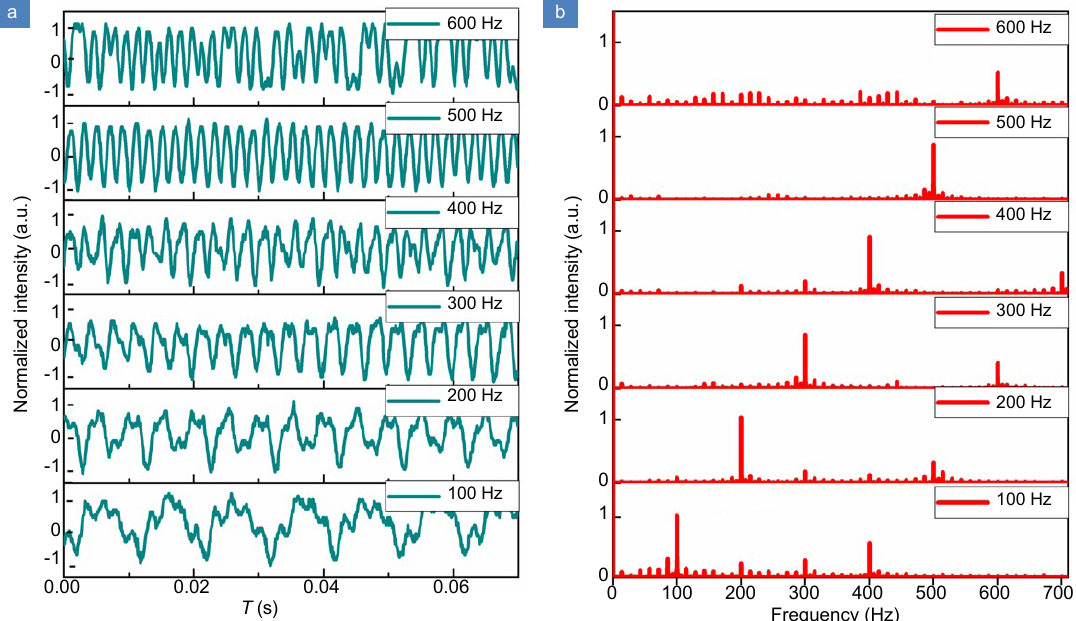
Fig. 5 | The scattered light signals of one trapped vaterite particle. ( a ) The signals of the probe laser scattered by rotating vaterite particle at heterodyne frequency tuned with the step of 100 Hz. ( b ) The frequency spectra obtained by Fourier transform to the signals in